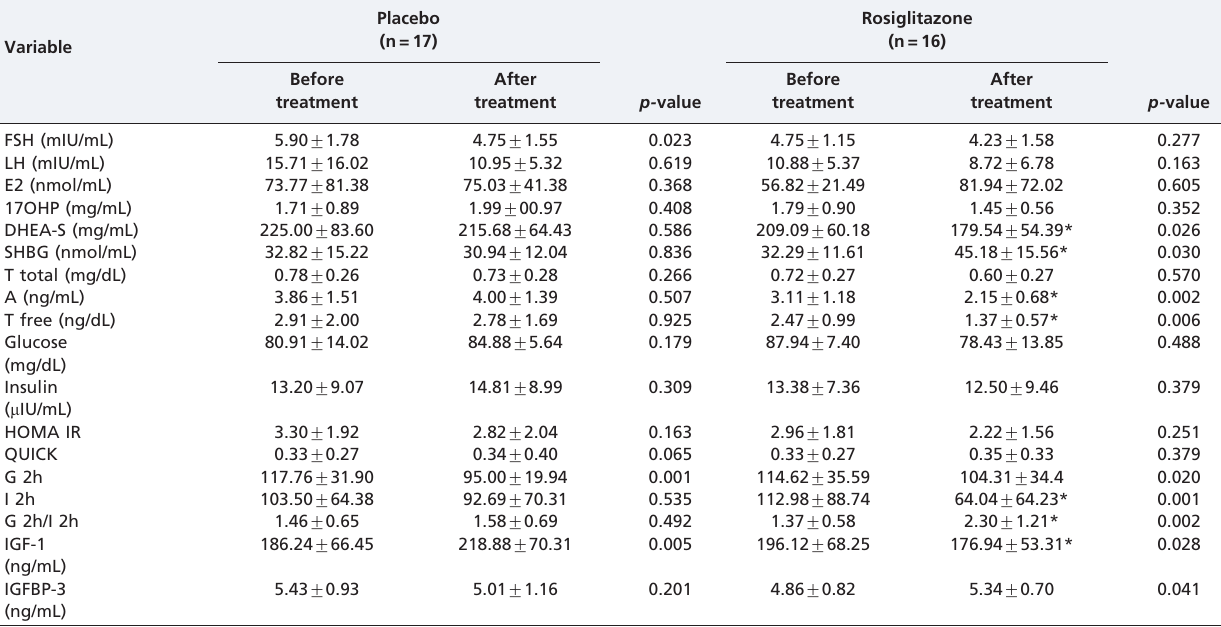
Table 2 - Hormone values, SHBG values, and glycemia, insulin, type 1 insulin-like growth factor (IGF-1), and type 3 insulin-like growth factor-binding protein (IGFBP-3) levels of the women with PCOS in both the placebo and rosiglitazone groups (means ¡ standard deviations).